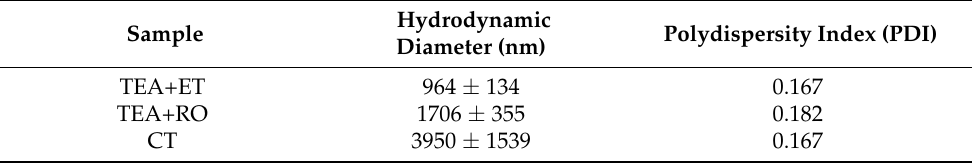
Table 3. Hydrodynamic diameter and polydispersity index of different experimental groups mea- sured by DLS in PBS (Detection immediately after preparation).